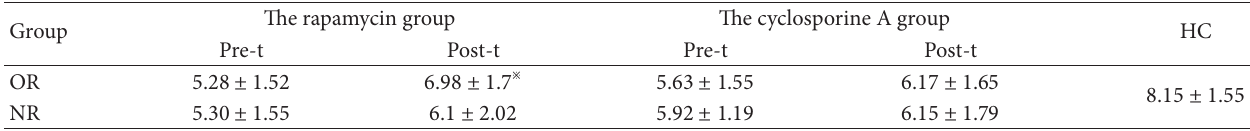
Table 2: The level of Treg cells before the treatment and after the treatment.